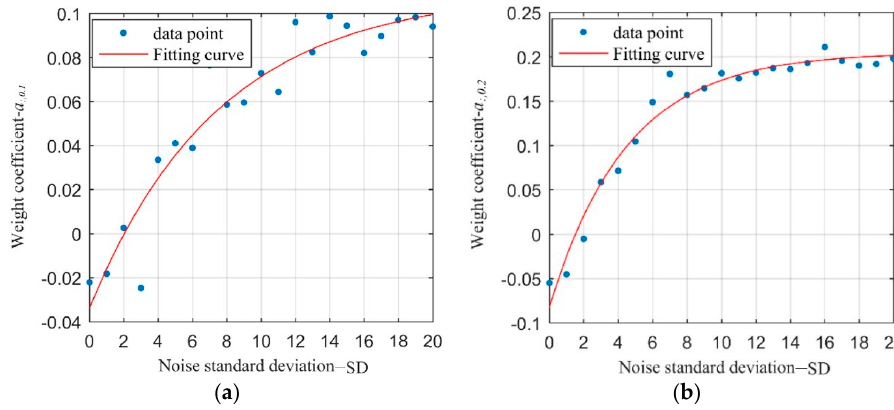
:,d : ( a ) a :, 0.1 ; ( b ) a :, 0.2 .